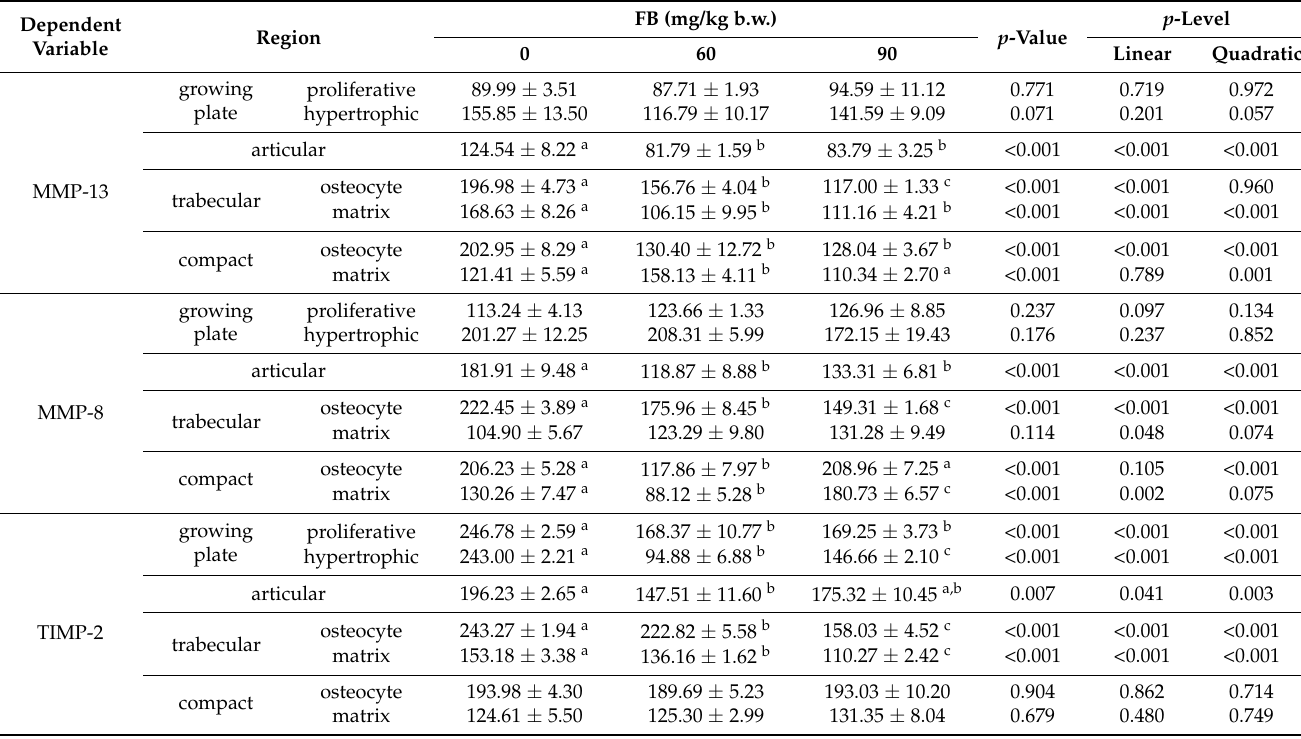
Table 3. The intensity of MMP-13, MMP-8 and TIMP-2 immunoreaction in bone and articular tissue of male rat offspring following maternal exposure to 0, 60 and 90 mg/kg b.w. of